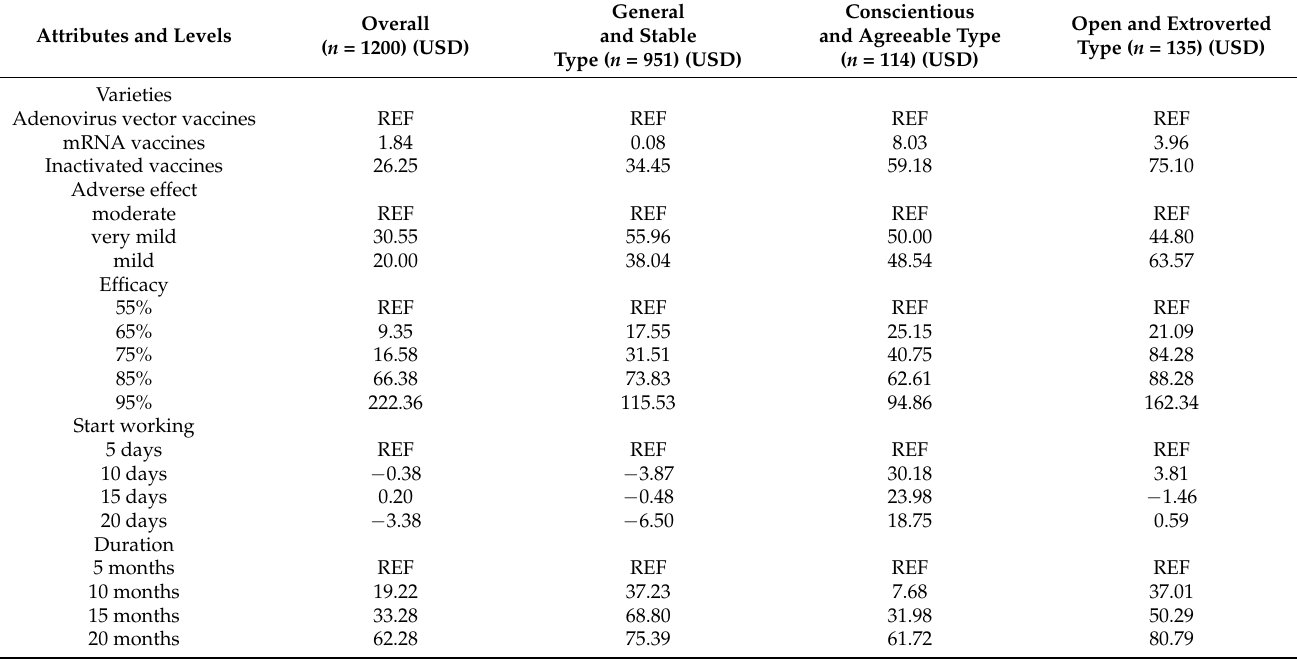
Table 6. WTP a of respondents with different personality traits b